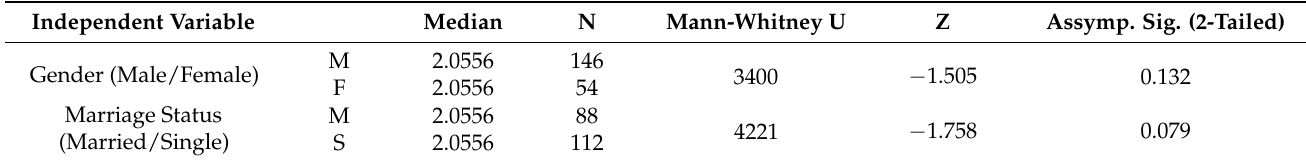
Table 4. Mann-Whitney U